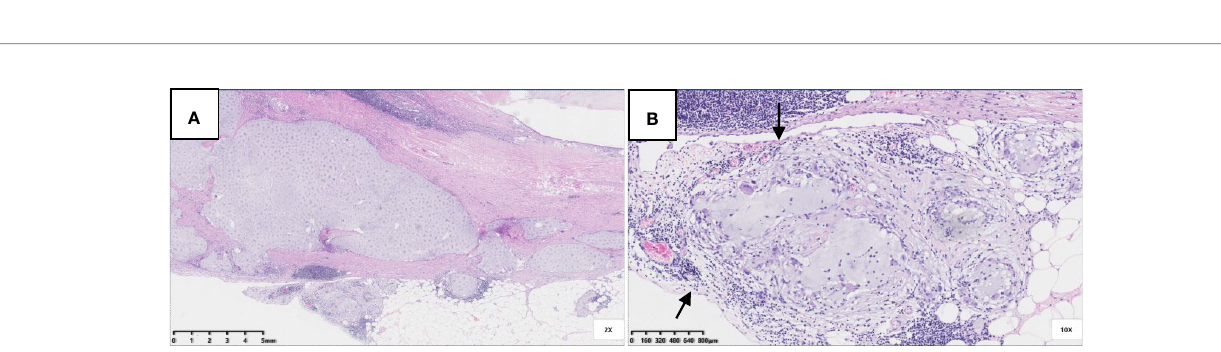
Frontiers in Oncology |